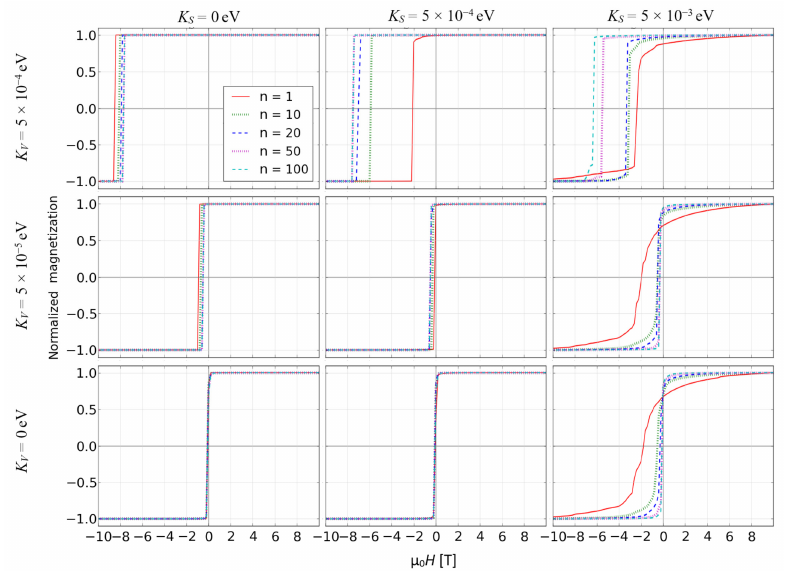
Figure 2. Reverse magnetization curves for all examined objects with N S /( N S + N V ) = 0.7 and S =